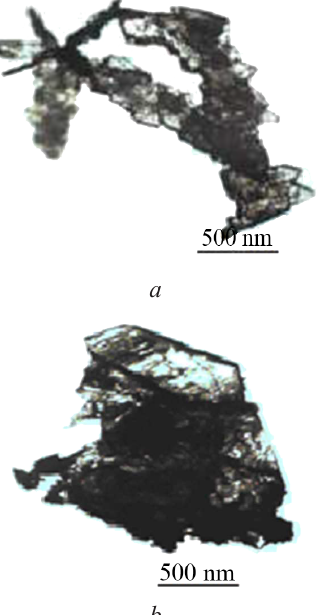
b Fig. 3. Pinostrobin crystals: a – before recrystallization; b – after recrystallization